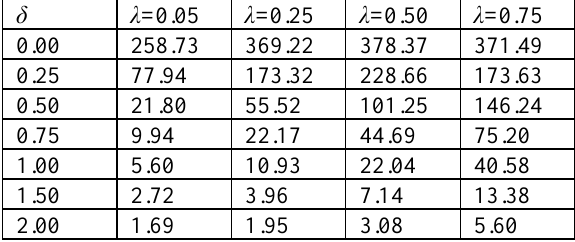
Table 6. MRLs for the EWMA median chart based on RSS scheme